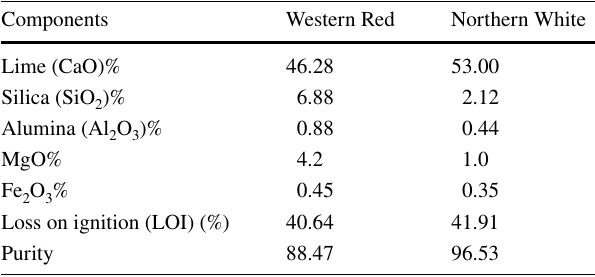
Table 4 Chemical characterization of the limestone used in the